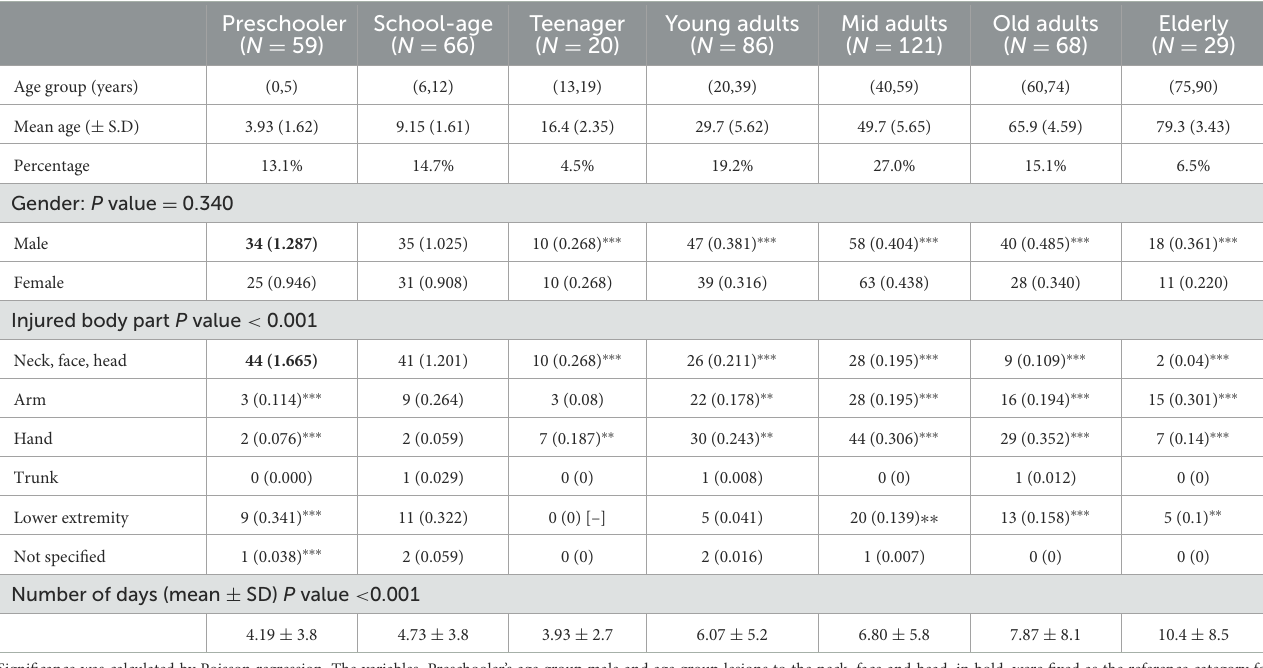
TABLE 2 Distribution of dog bite injuries hospitalizations (DBIH) and incidence per 100,000 inhabitants in Sicily between 2012–2021 according to age and sex of patients, principal lesion location and number of days of